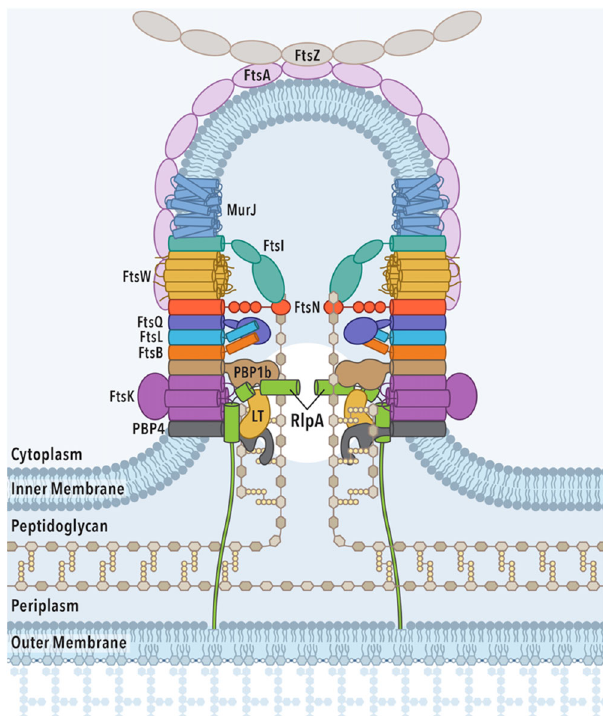
Fig. 8 RlpA and its recruitment of binding-partners for the divisome during daughter-cell separation. This perspective illustrates a single snapshot of the entire daughter-cell-separation process. The placement of RlpA and select binding partners spatially demonstrate the interrelationship of such protein – protein interactions for the purposes of peptidoglycan denuding, orthogonal growth of the peptidoglycan, and as components for the multi-enzyme divisome complex. C2 symmetry within the septum is shown. “ LT ” placeholder can equate to LT binding partners; SltB1,